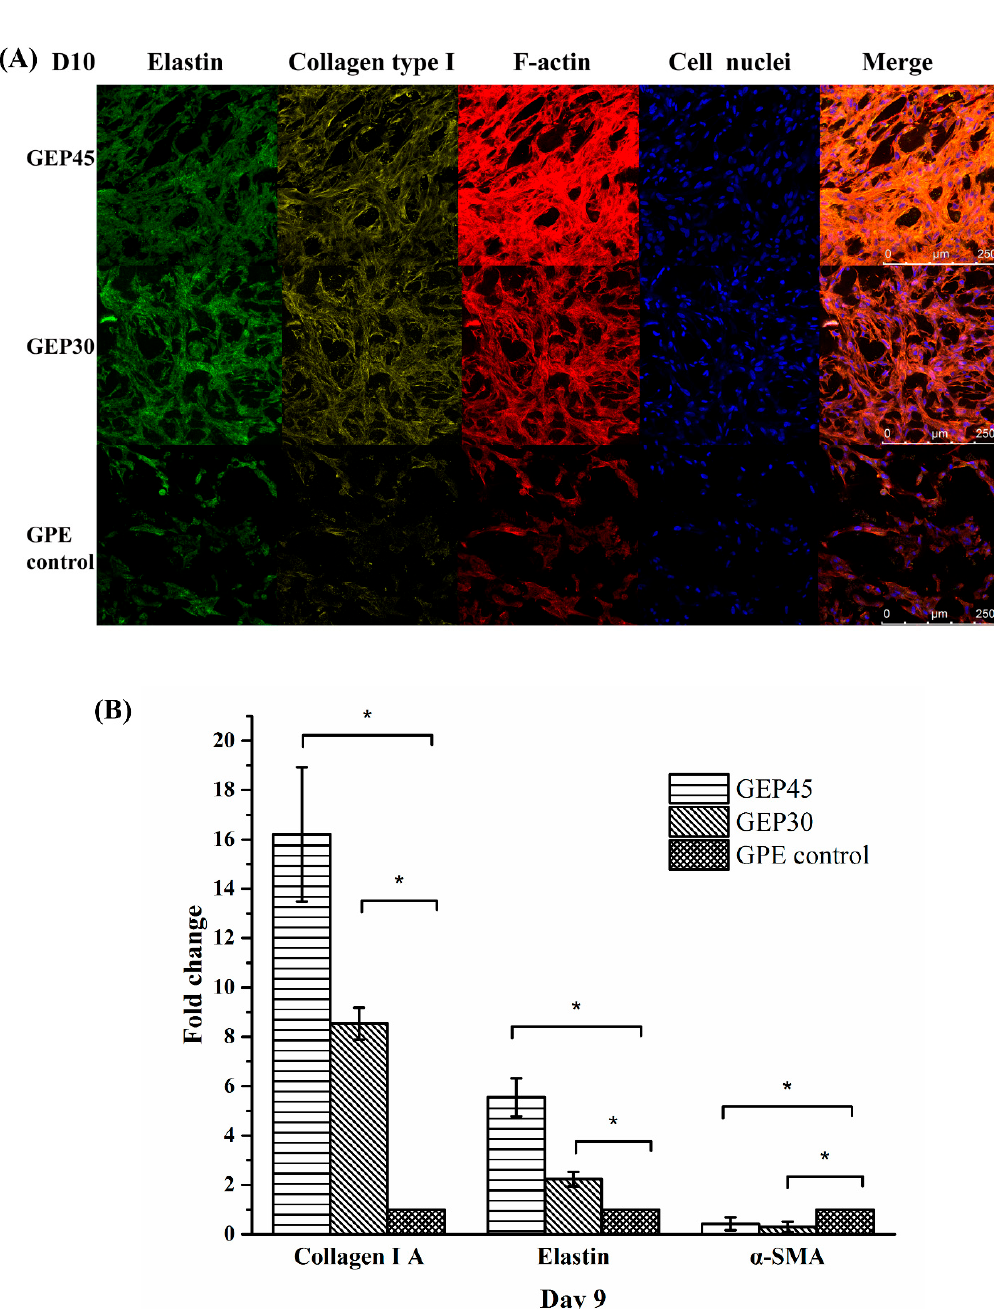
Figure 7. ( A ). Immunofluorescence staining for elastin (green), collagen type I (yellow), F-actin (red) and nucleic acid (blue) in GEP45, GEP30, and GPE control at day 10. Scale bar=250 µm. The antibodies of collagen type I and elastin only can be used for human source samples. The immunofluorescence staining images of cell-free hydrogel were showed in supporting file as the controls. ( B ) Effect of elastin addition on ECM proteins (COL1A1, ELN, and α -SMA) gene expression on day 9. Elastin addition resulted in a significant increase in collagen 1A1 and elastin at day 9. Gene expression was normalized to the housekeeping gene GAPDH and expressed as fold change versus NHDFs seeded GPE control hydrogels (considered as 1) at day 9. * denote p<0.05. n=4.